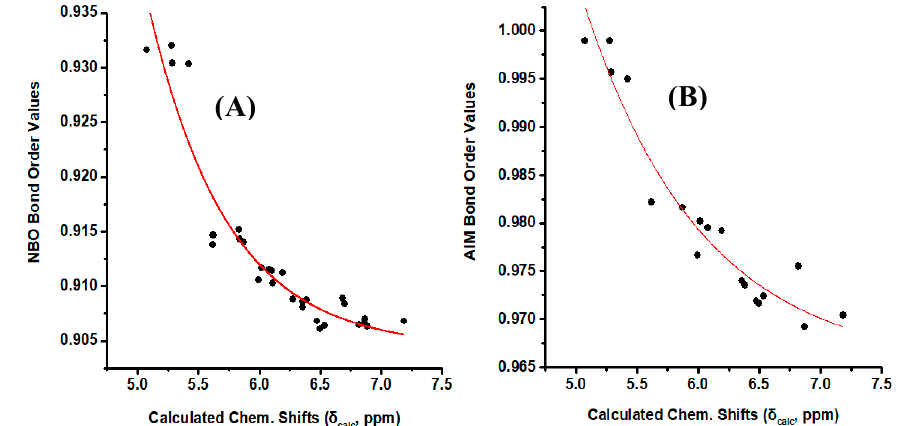
Figure 8. ( A ) NBO bond order of the olefinic C–H bonds of the model compounds of Figure 1 vs. calculated, δ calc , 1 H-NMR chemical shifts with energy minimization at the B3LYP / 6-31 + G(d) level. ( B ) AIM bond order of the olefinic C–H bonds of the model compounds ( Z )-1,3-pentadiene, ( E )-1,3 pentadiene, ( E,Z )-2,4 hexadiene, ( E,E )-2,4 nonadiene vs. calculated, δ calc , 1 H-NMR chemical shifts with energy minimization at the B3LYP / 6-31 + G(d) level.